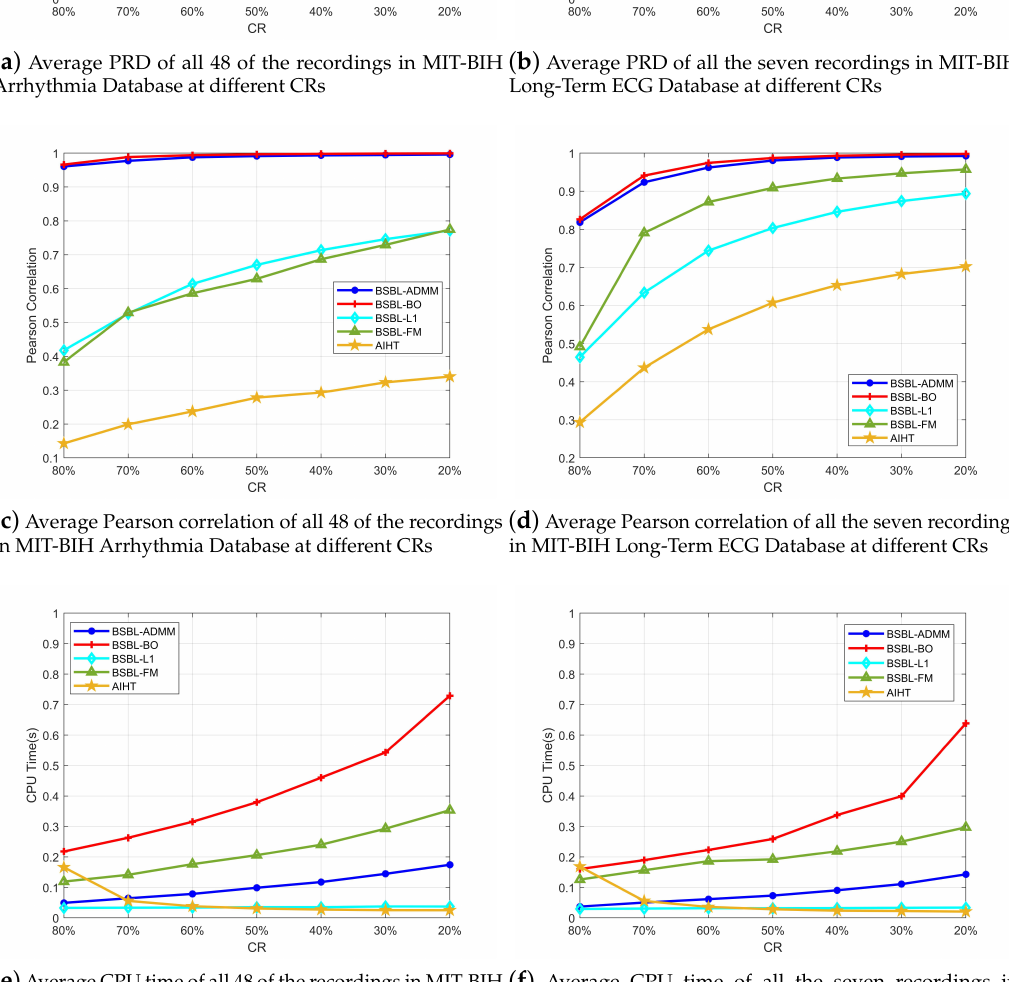
Figure 4. Recovery results of all 48 of the recordings in MIT-BIH Arrhythmia Database and seven recordings in MIT-BIH Long-Term ECG Database at different CRs (compression ratios). ( a – d ) show that the PRD (percentage root-mean squared distortion) and Pearson correlation of BSBL-ADMM are very close to BSBL-BO, the other three have much worse recovery accuracy; ( e , f ) show that the BSBL-ADMM is much faster compared with BSBL-BO. These results on MIT-BIH Databases demonstrate that the proposed BSBL-ADMM algorithm has both satisfactory speed and accuracy compared with the other